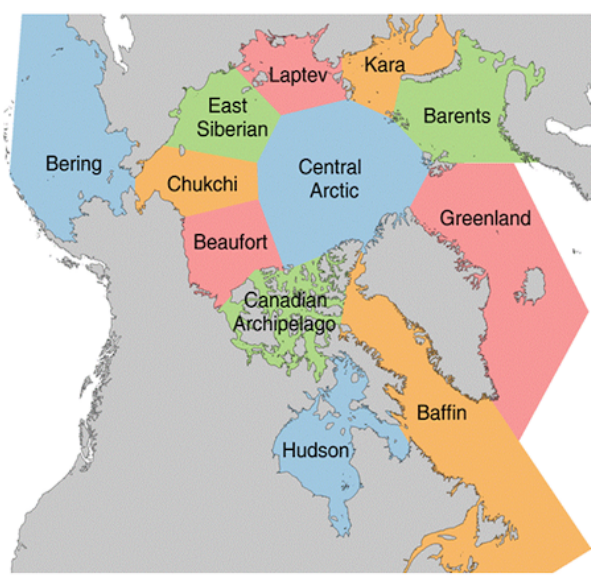
Figure 3. The MASIE subregions of the Arctic. Regions utilized in this study include the Beaufort Sea, Chukchi Sea, East Siberian Sea, Laptev Sea, Kara Sea, Baffin Bay, Hudson Bay, and Bering